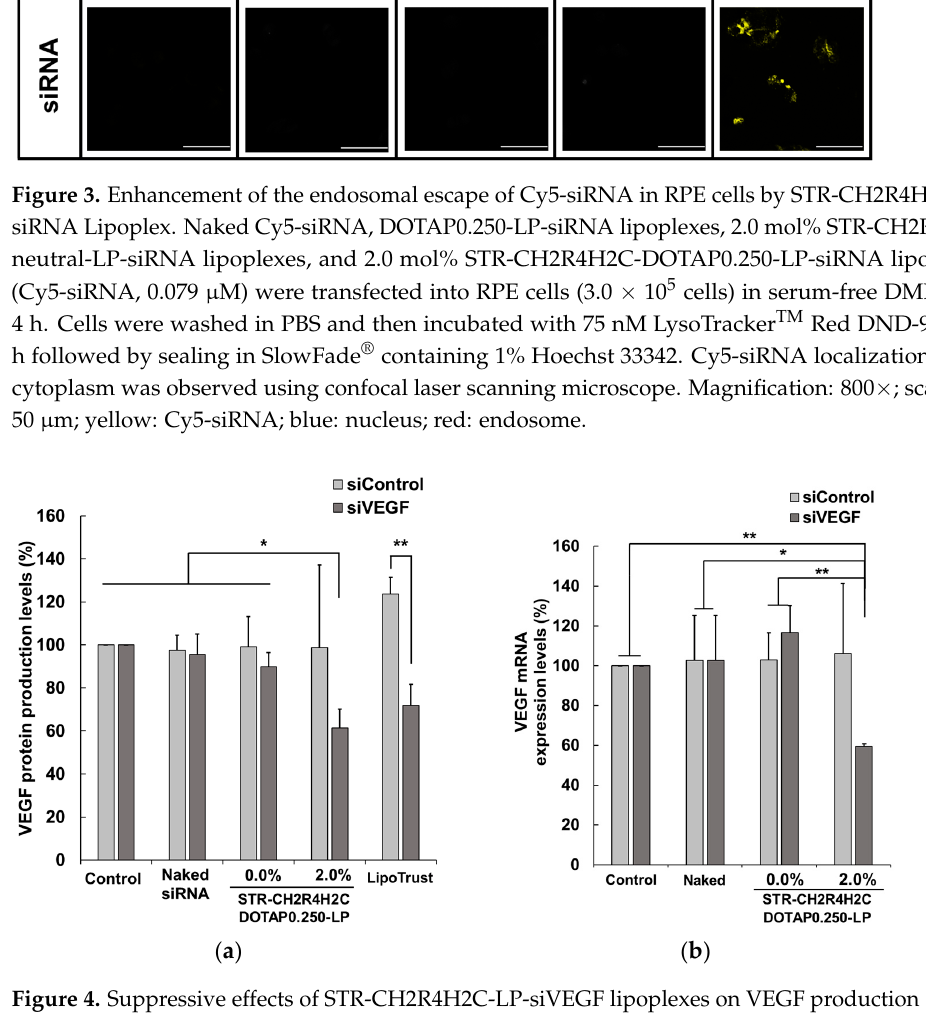
Figure 3. Enhancement of the endosomal escape of Cy5-siRNA in RPE cells by STR-CH2R4H2C-LP-